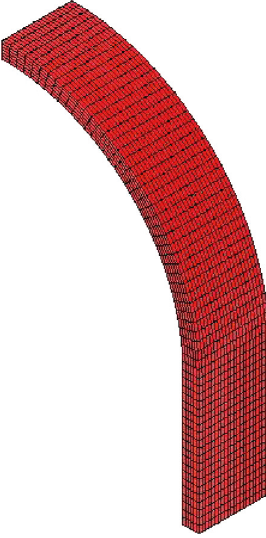
Figure 6: Numerical model.